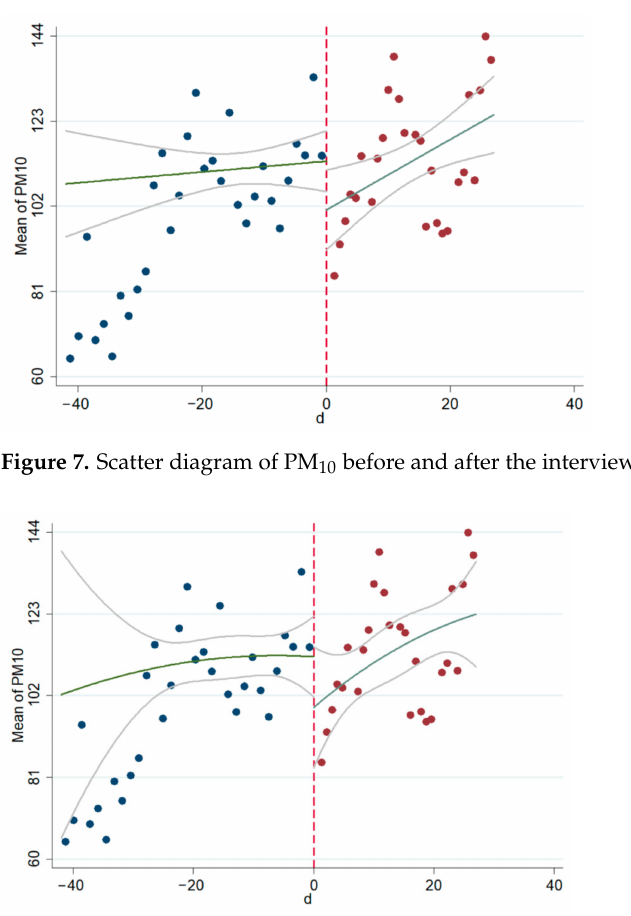
Figure 8. Scatter diagram of PM 10 before and after the interviews